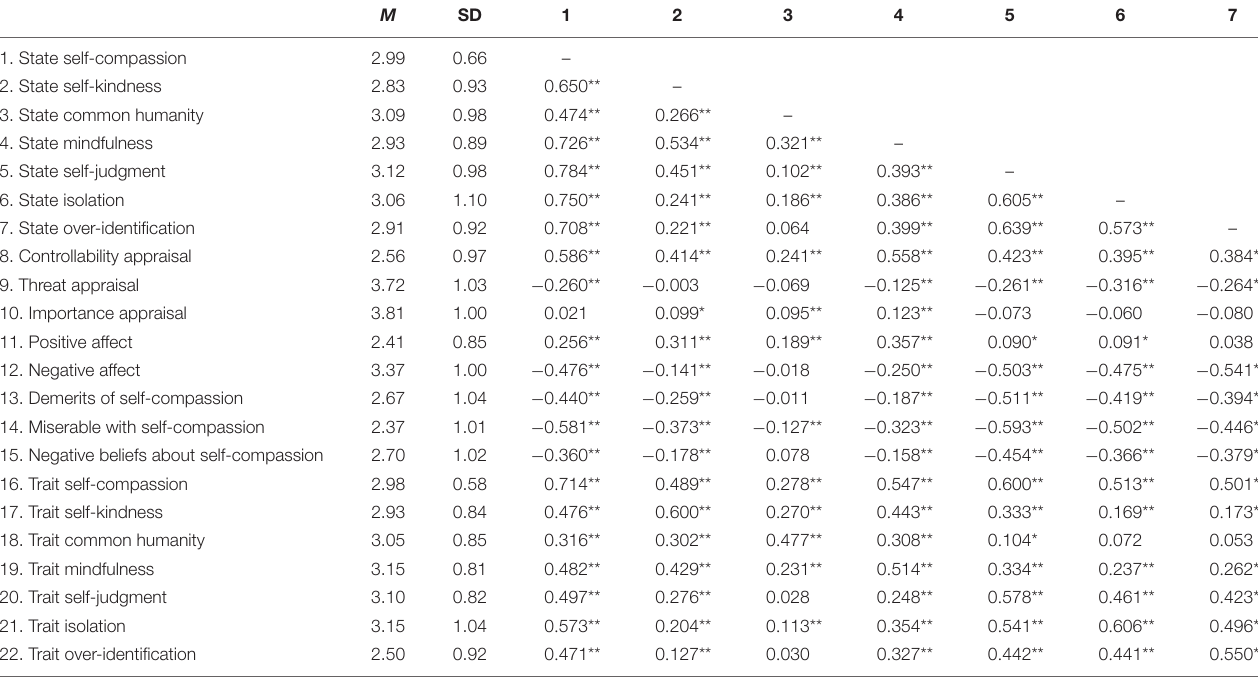
TABLE 5 | Descriptive statistics of and Pearson’s correlations between state self-compassion and other study variables in Study 1. M